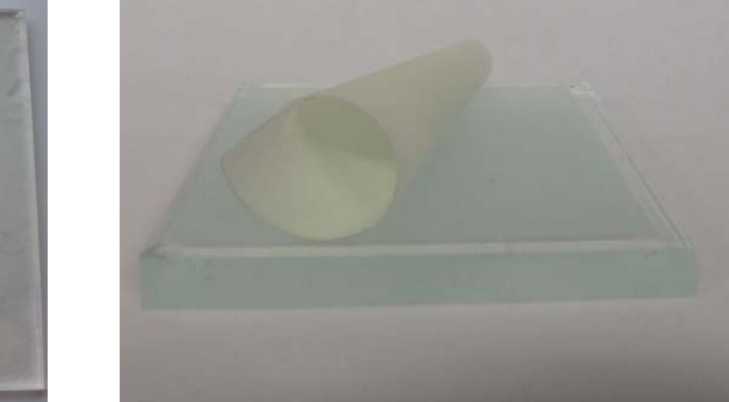
Fig. 24 Delamination of the sample with the paint between two films